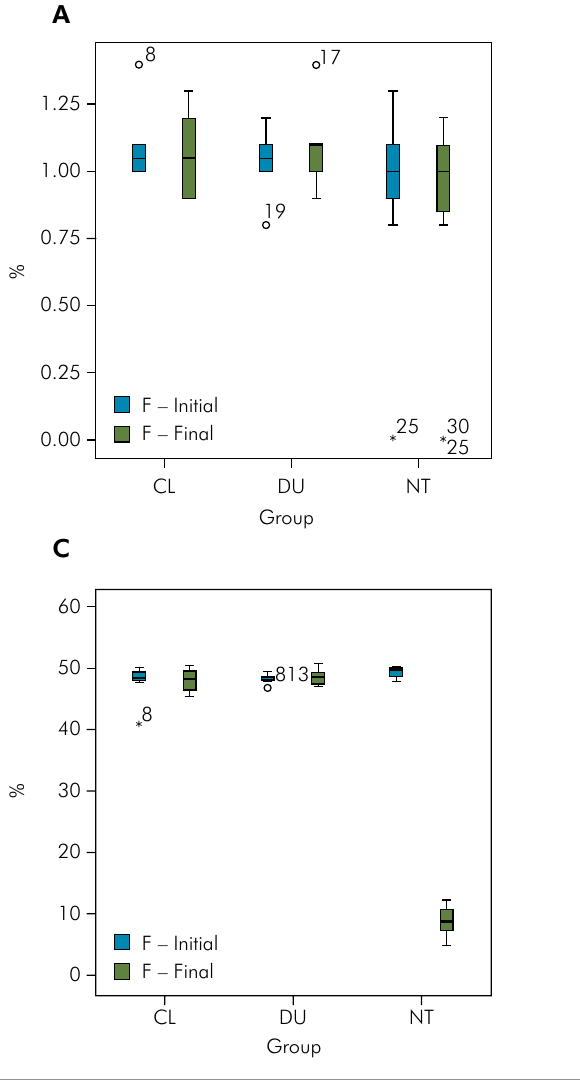
Figure 6. Atomic percentages of F (A), P (B), and Ca (C) on the enamel determined by